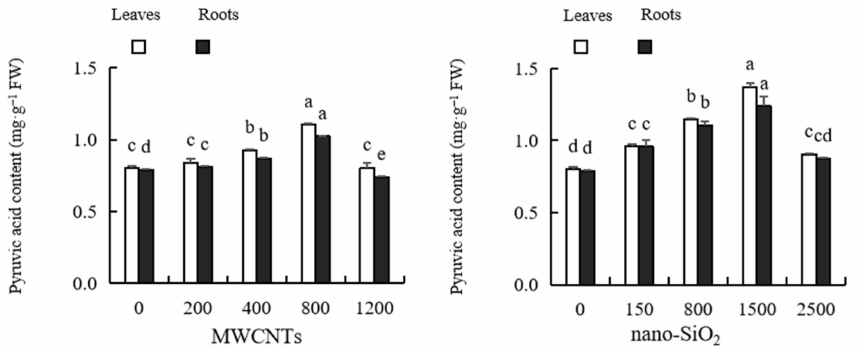
Figure 7. Effect of different concentrations of MWCNTs and nano-SiO 2 on pyruvic acid content in maize. Note: Data are expressed as mean ± standard deviation. Different letters within the same column indicate significant difference at 5%